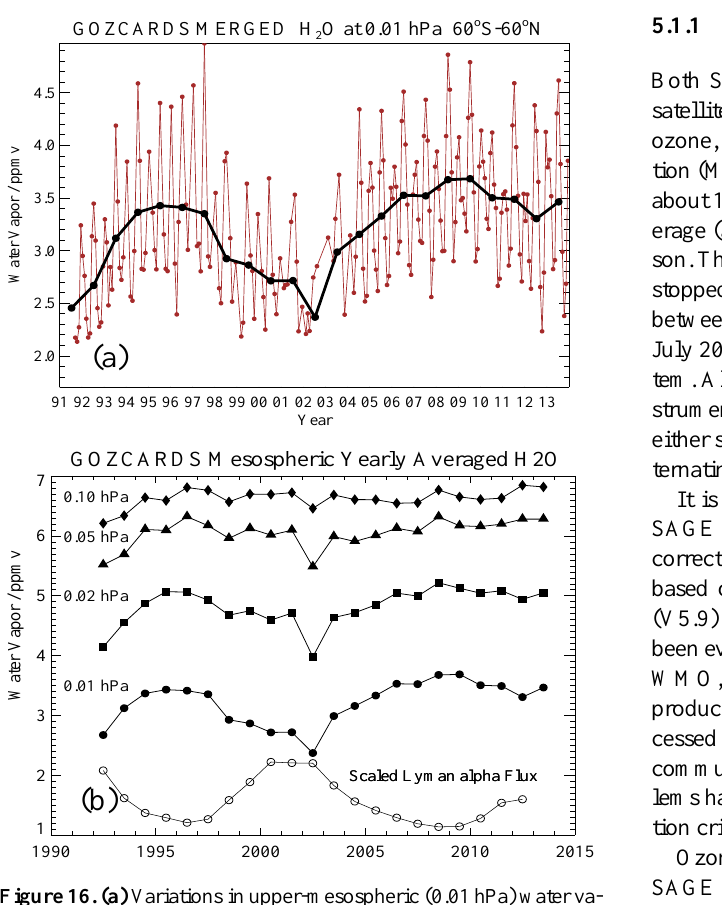
Figure 16. (a) Variations in upper-mesospheric (0.01hPa) water va- por mixing ratios averaged from 60 ◦ S to 60 ◦ N for October 1991 through December 2013, based on the GOZCARDS merged H 2 O data records. Monthly average values and annual averages are shown by connected brown dots and connected black dots, respec- tively. (b) GOZCARDS merged H 2 O annual averages (connected filled symbols) from 60 ◦ S to 60 ◦ N for 1992 through 2013 at pres- sure levels between 0.1 and 0.01hPa. A time series of annually av- eraged Lyman α solar flux values (open circles), scaled to arbitrary units, is also displayed (see